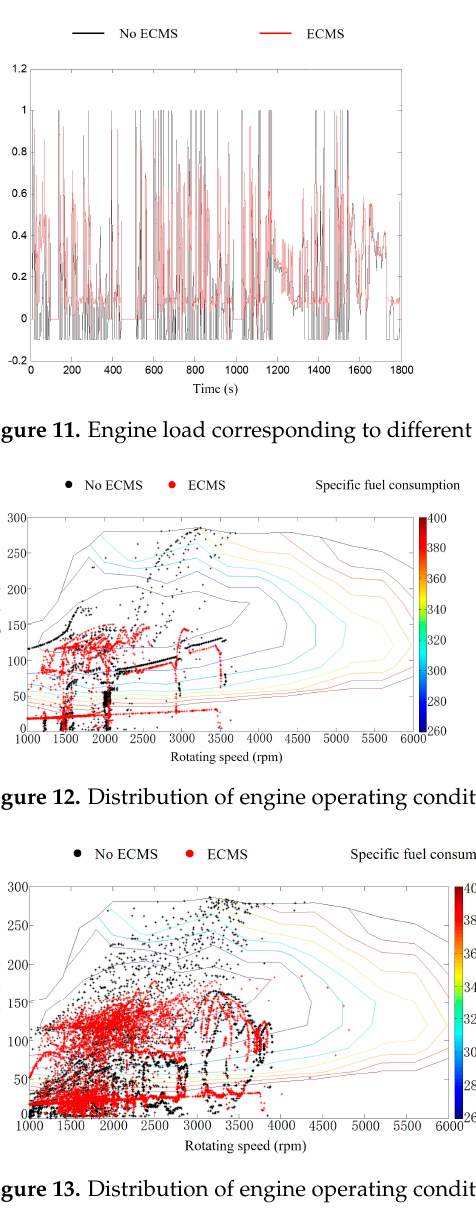
Figure 10. Motor output torque after ECMS control strategy participation under WLTP test conditions.